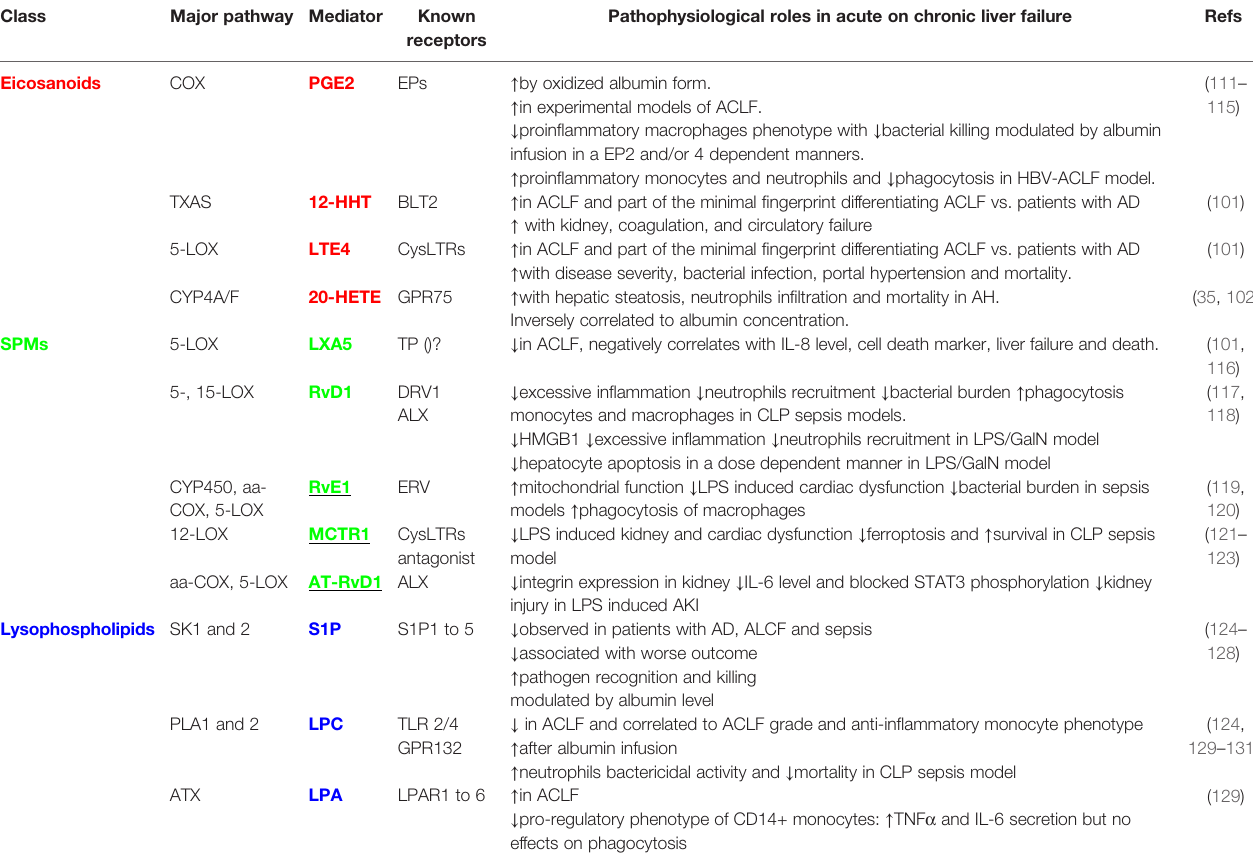
TABLE 2 | Eicosanoids, specialized pro-resolving mediators (SPMs) and lysophospholipids and their known pathways involved in acute on chronic liver